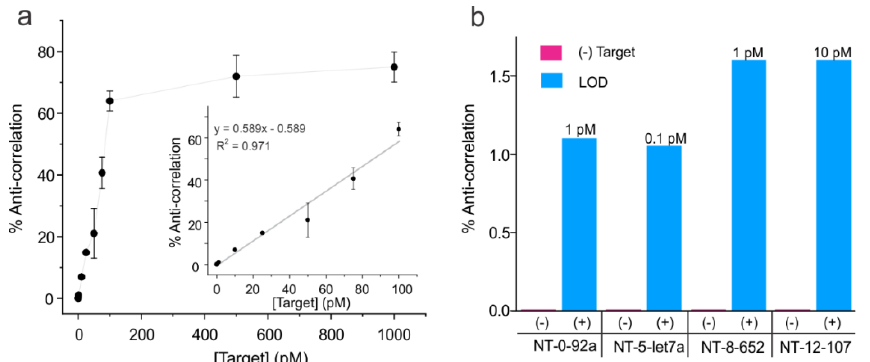
Figure 4. Analytical sensitivity of the NT sensors. ( a ) Full calibration curve showing the percentages of molecules showing anti-correlation in the donor-acceptor intensities out of the total single molecules against the target (DNA92a) concentration for NT-0. The inset depicts the linear region of the curve with a linear fit. Error bars represent standard deviations in the mean percentages of anti-correlated molecules obtained by assigning the molecules of a given target concentration into three groups (n = 3). A linear range up to 100 pM was observed, after which the data began to plateau, suggesting saturation of the NT-0 sensor. All data points were obtained by analyzing ~113–261 molecules. ( b ) Bar graph showing percentages of anti-correlation values for (-) target controls and the lowest target concentration tested to provide a positive signal (+ target data) for each target-specific NT sensor (i.e., limit of detection or LOD). All data were obtained from the analysis of ~125–238 molecules. The targets 92a, let7a, 652, and 107 refer to the DNA mimics as shown in Table S1.